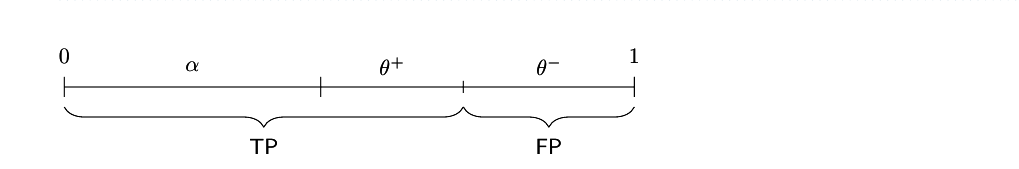
Figure 5. Decision theory evidences obtained from logistic regression. A logistic regression of IHC receptor status (IHC + 1, IHC - 0) versus gene expression ( x Expr ) was performed to obtain the responsibility function for receptor positivity r + (dotted red curve) and r - (dotted blue). It will be shown later (Eq. 6) that r + has to be ≙ ≙ multiplied by an upper limit, = β IHC · r − x Expr x Expr (solid blue). Uncertainty: ochre. For a given expression value, (cid:31) curve. Likewise β Expr (cid:31) (cid:30) (cid:31) (cid:30) e.g. x Expr = 2, one can read off belief in positive ( α ), belief in negative ( β ) and uncertainty ( θ ). (cid:29)